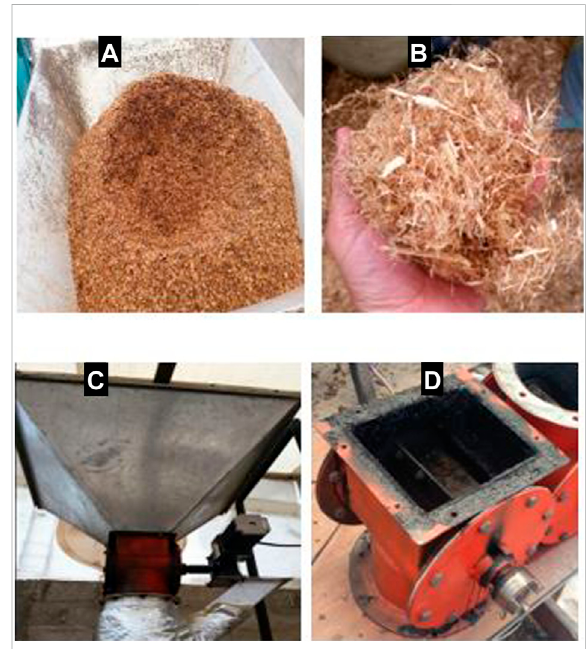
FIGURE 3 (A) Mass of static bulk material around a void observed in the centerinthepyrolysismodulehopper while conveying LS andLSC towards the carbonization chamber. (B) Scourers found in the hopper that result from the interaction between LS and LSC particles with small broken fi bers. (C) Pyrolysis module hopper with cover and rotaryvalve. (D) Failure of seals and tars condensed in the rotary vane